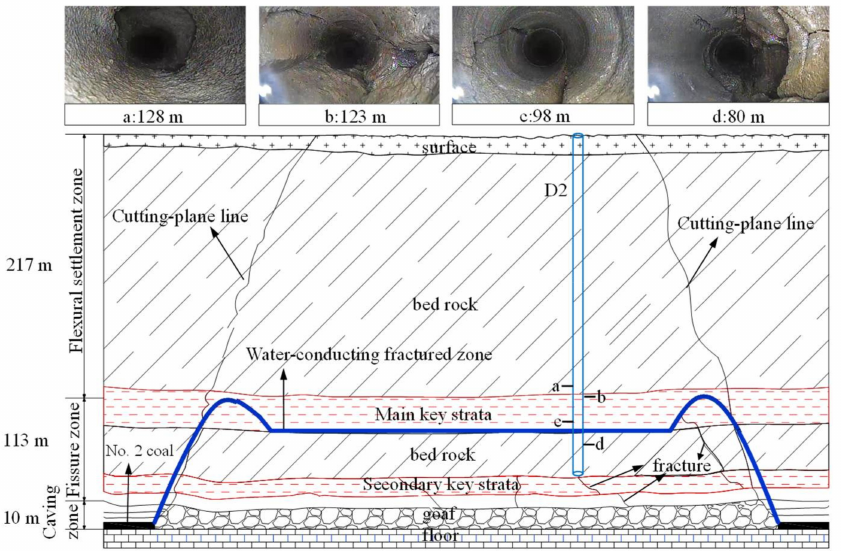
Figure 14. Study on the integrity of the water-conducting fracture zone and borehole peeping in the working